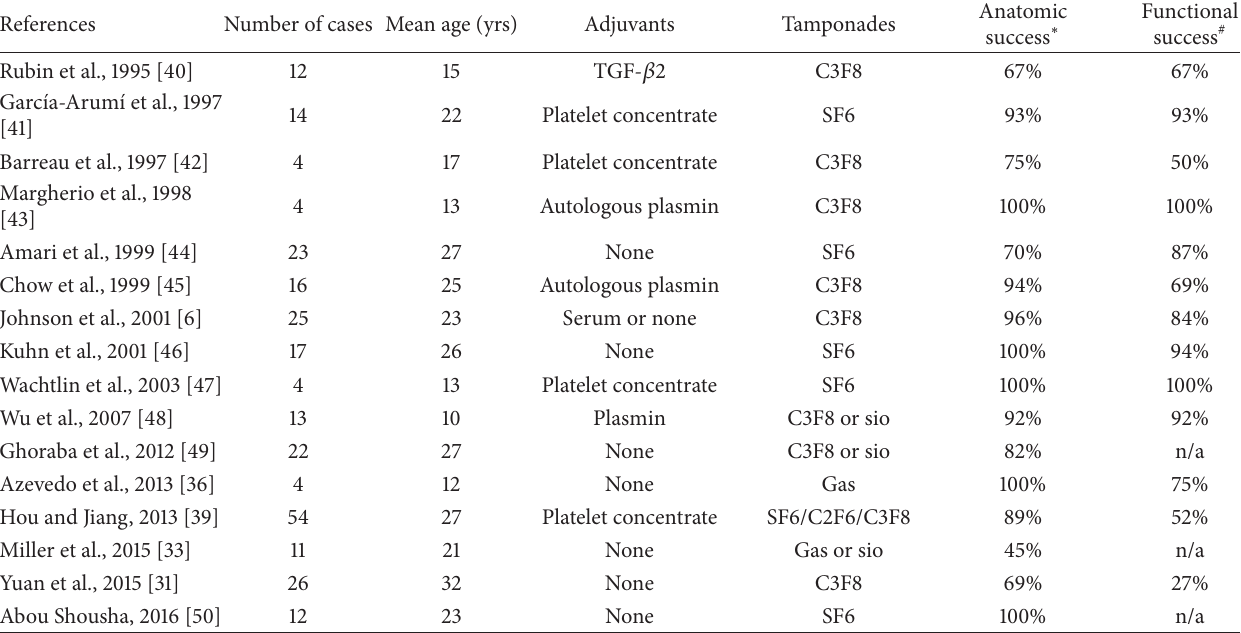
Table 3: Literature review of reports on vitrectomy outcomes for